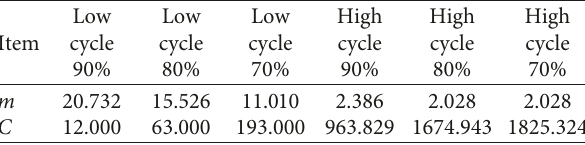
Table 4: Loosening D-N curve constant solution.